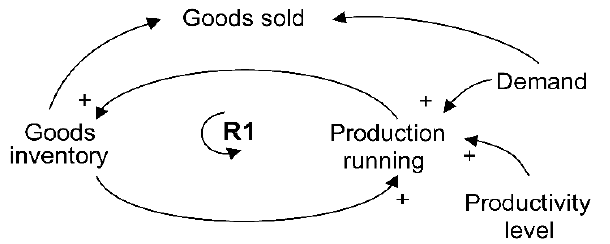
Figure 2. Causal loop diagram (CLD) with reinforcing loop (R1) in production operation.